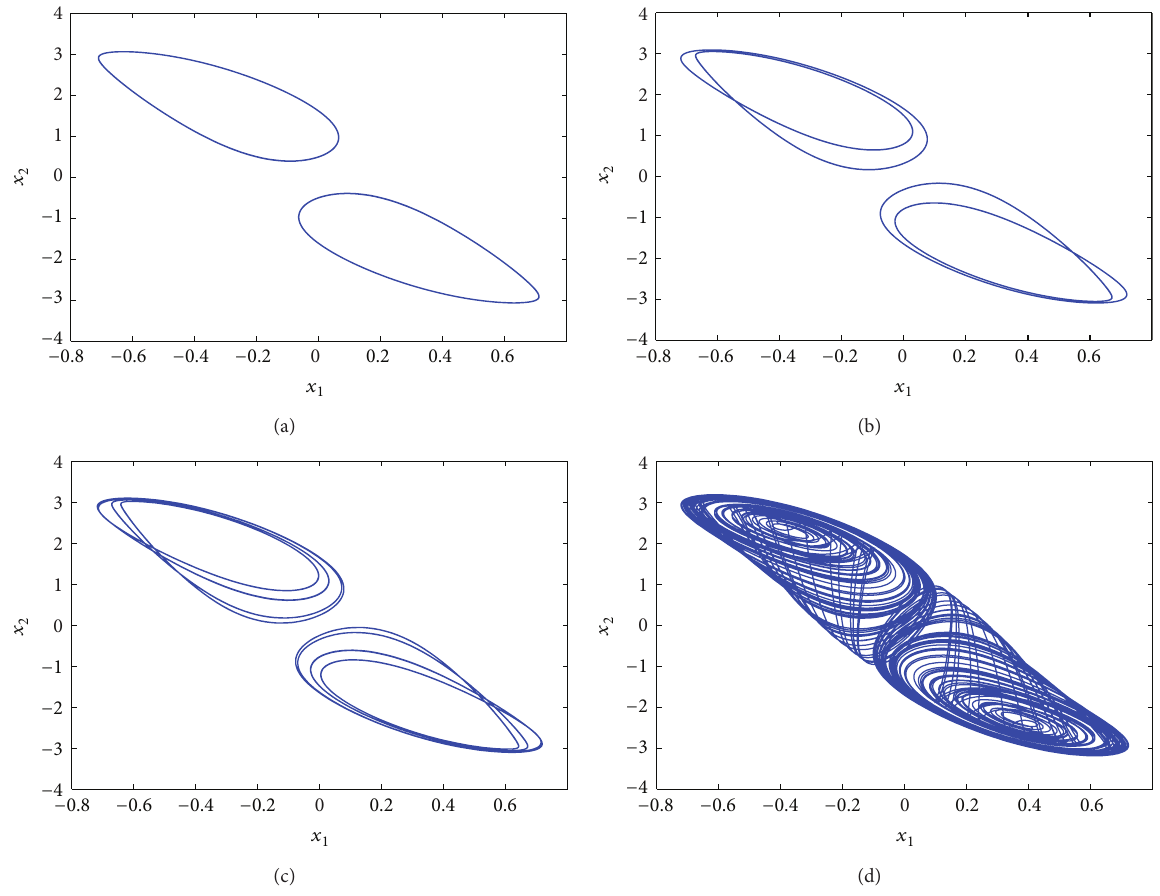
Figure 1: Different dynamical behaviors of system (13) with fixed parameter values 𝑏 22 = 2.0 , 𝑐 22 = −1.5 and two groups of initial conditions (0.4, 0.6) 𝑇 and (−0.4, −0.6) 𝑇 for 𝑡 ∈ [−1,0] , respectively; (a) period-one orbits when 𝛼 = 0.82 ; (b) period-two orbits when 𝛼 = 0.84 ; (c) period-four orbits when 𝛼 = 0.85 ; (d) separate single-scroll chaotic attractors when 𝛼 = 0.90 .